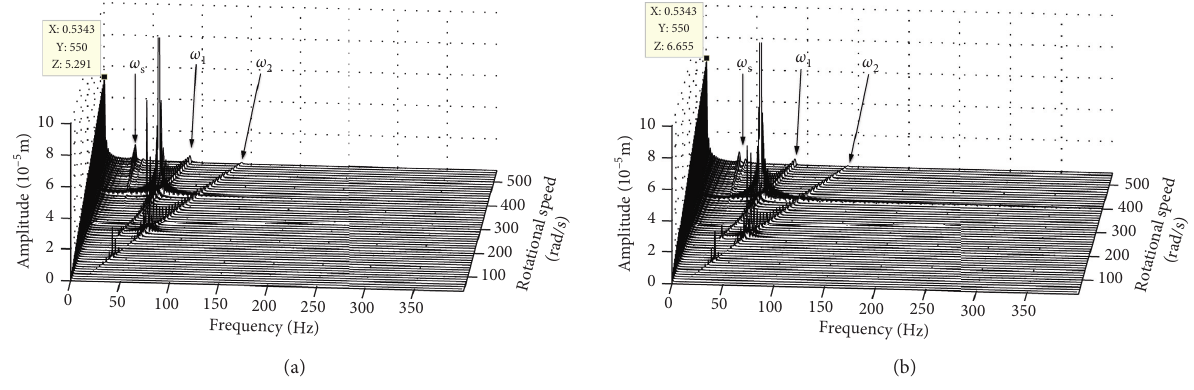
Figure 19: Vertical response of disk 3. (a) λ � 1 . 6. (b) λ � − 1 .